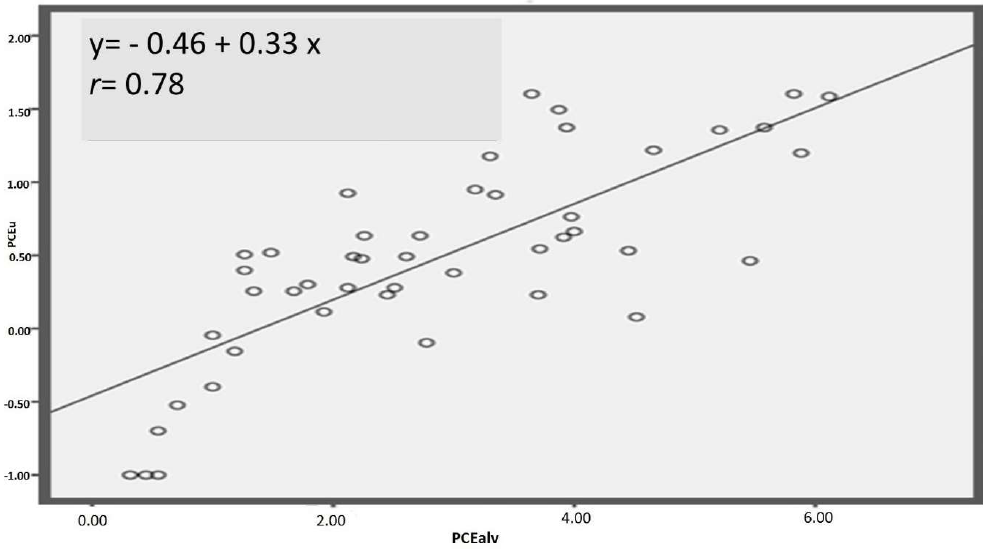
Figure 5. Correlation between PCE concentration in the urines of the workers at the end of the work shift (PCE u , after base-10 logarithm transformation) and PCE concentration in the exhaled alveolar air at the end of the work shift (PCE alv , after square root transformation). The regression line equation and the Spearman r coefficient are also reported.